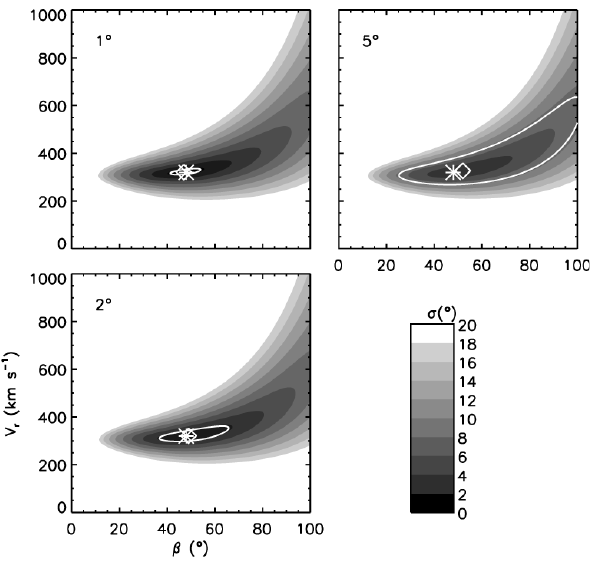
Fig. 4. Contour plots of the fit errors obtained when fitting elonga- tion variations corresponding to a track defined by V r =320kms − 1 and β =48 ◦ onto which three levels of random error have been added (with 1, 2 and 5 ◦ standard deviation – top left, bottom left and top right panels, respectively). Darker shades illustrate regions of lower fit errors, lighter shades reveal larger fit errors. The asterisk on each panel marks the input values, while the diamond marks the best fit values. The white contours here indicate a level equal to twice the minimum σ